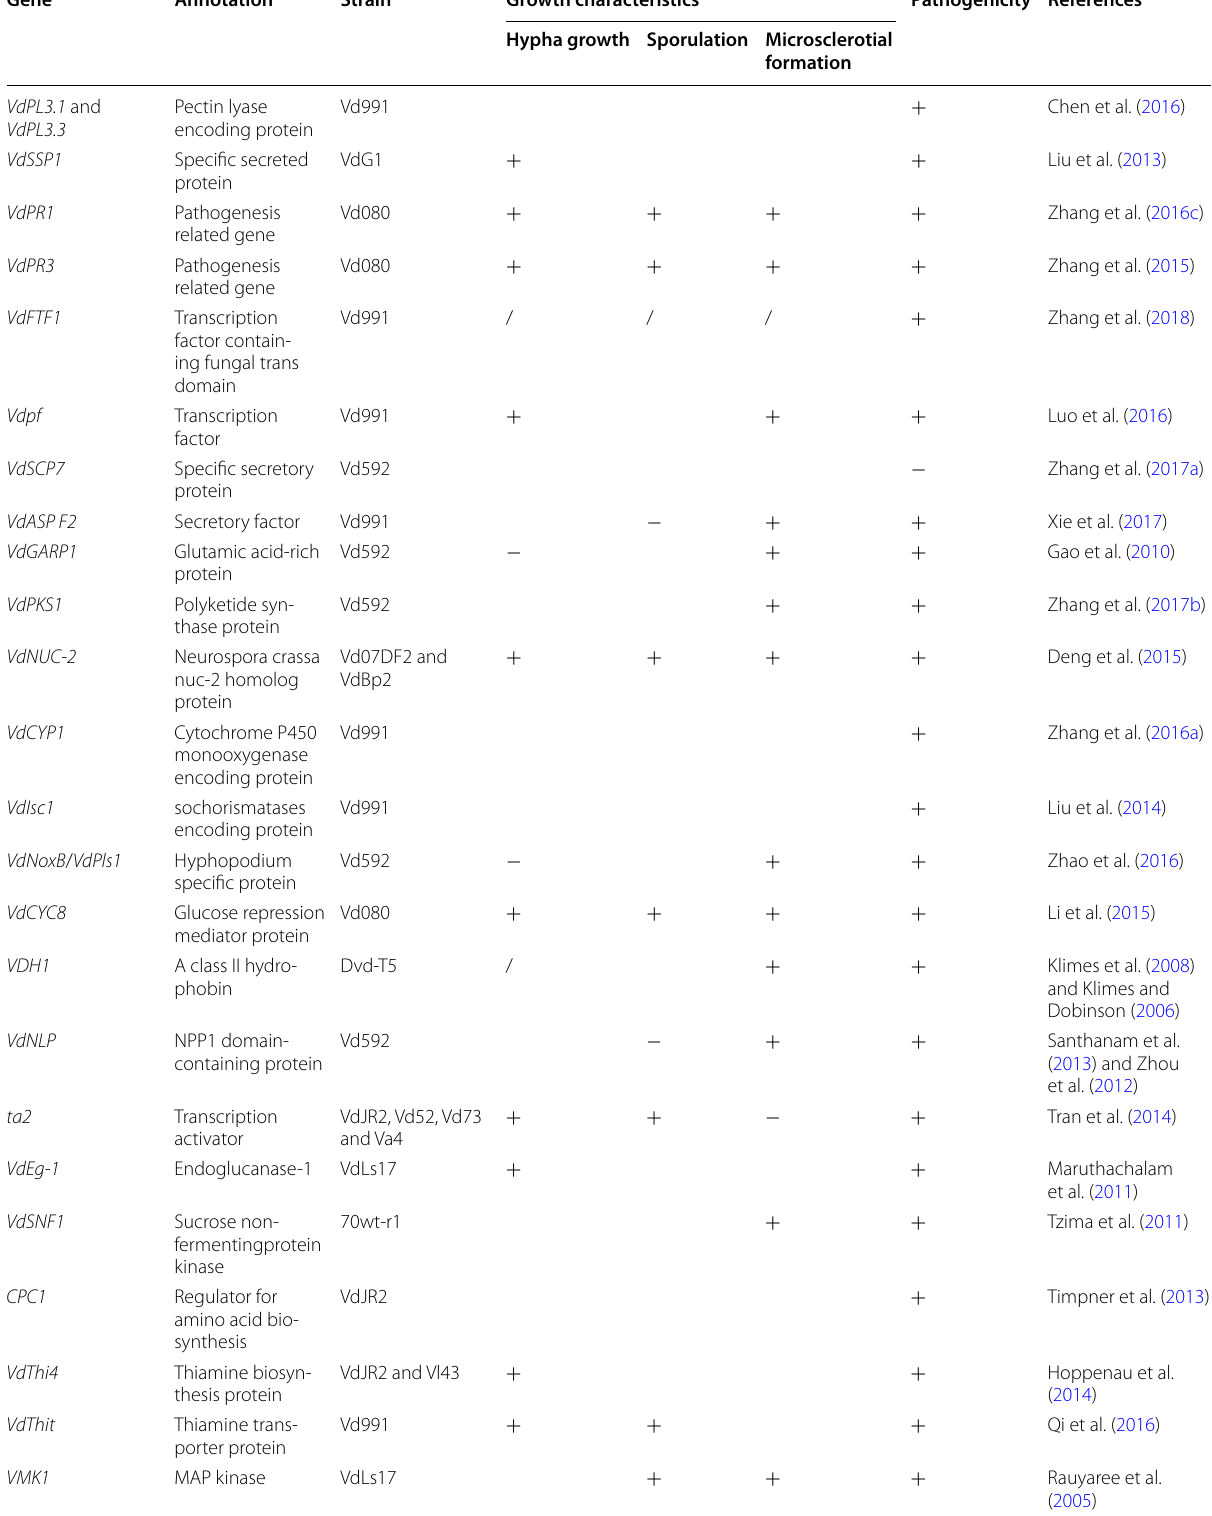
Table 1 Numerous genes directly/indirectly related to pathogenicity in V. dahliae Gene Annotation